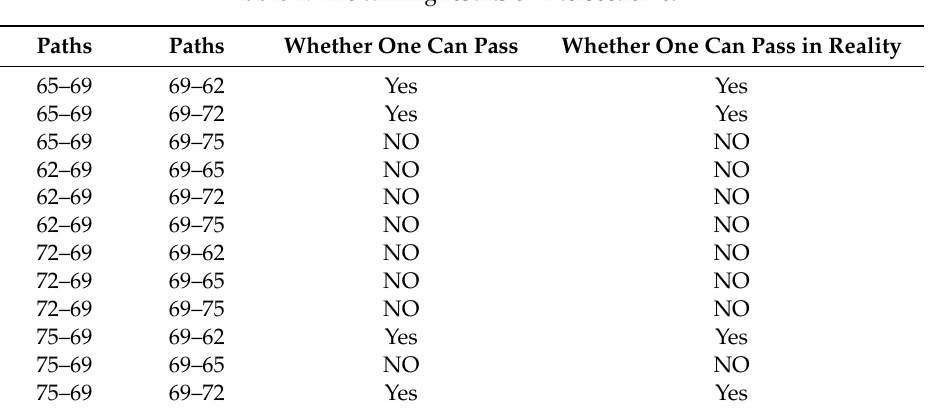
Table 4. The turning results of intersection 69.